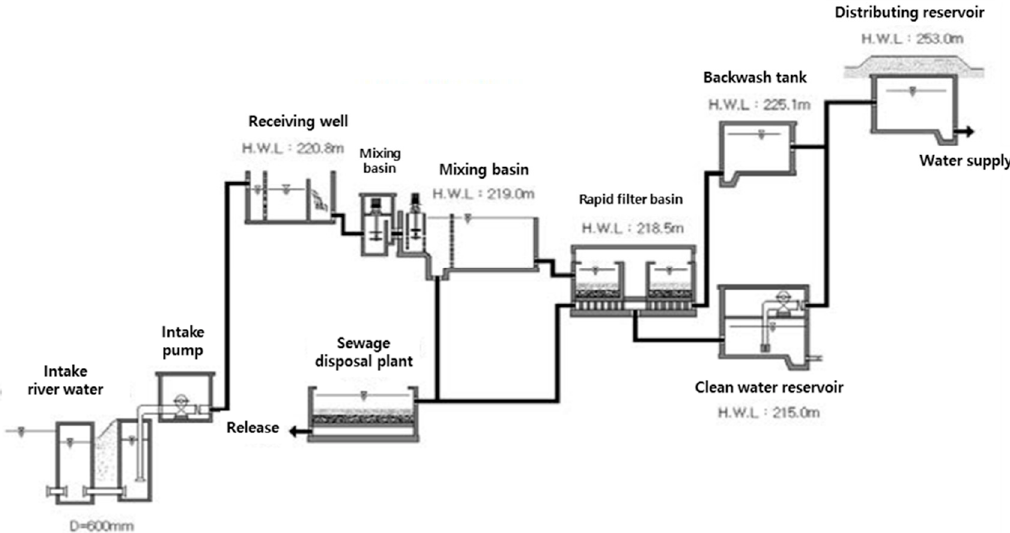
Figure 3. Process and system of TB (1).